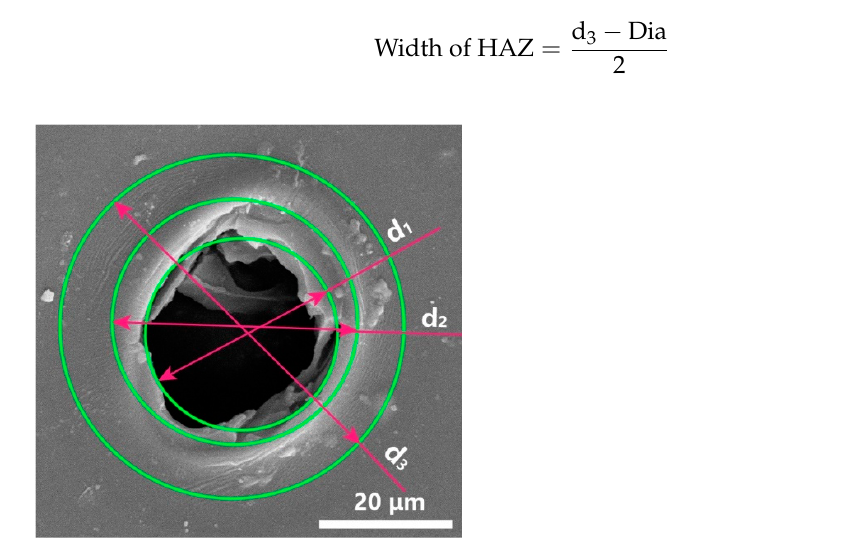
Figure 2. Schematic diagram of laser cutting quality evaluation. Based on this evaluation system, eight samples were selected in each parameter for the calculation of the evaluation indexes. Sample values of d 1 , d 2 , d 3 were obtained by averaging five measurements after removing maximum and minimum values. In addition, it was determined that the cutting parameter can cut the PI film only when all the micro- holes were through-holes. The typical micro-hole morphologies of each parameter are shown in Figure 3, and the statistical data are shown in Table 4. Micromachines 2021 , 12 , x FOR PEER REVIEW